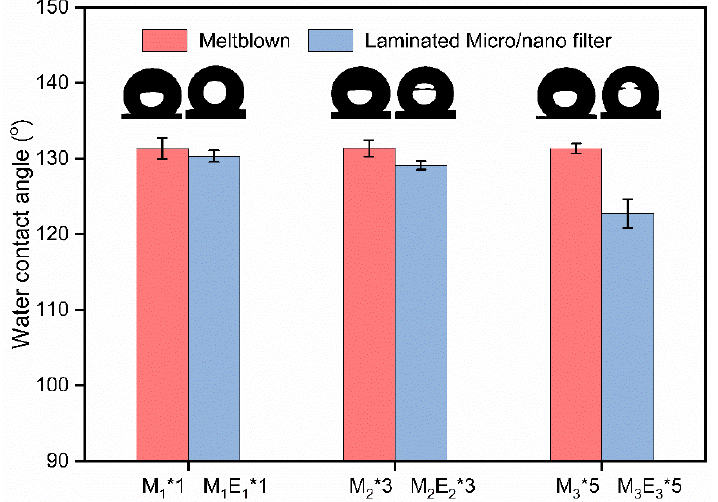
Figure 5. Water contact angles of samples.